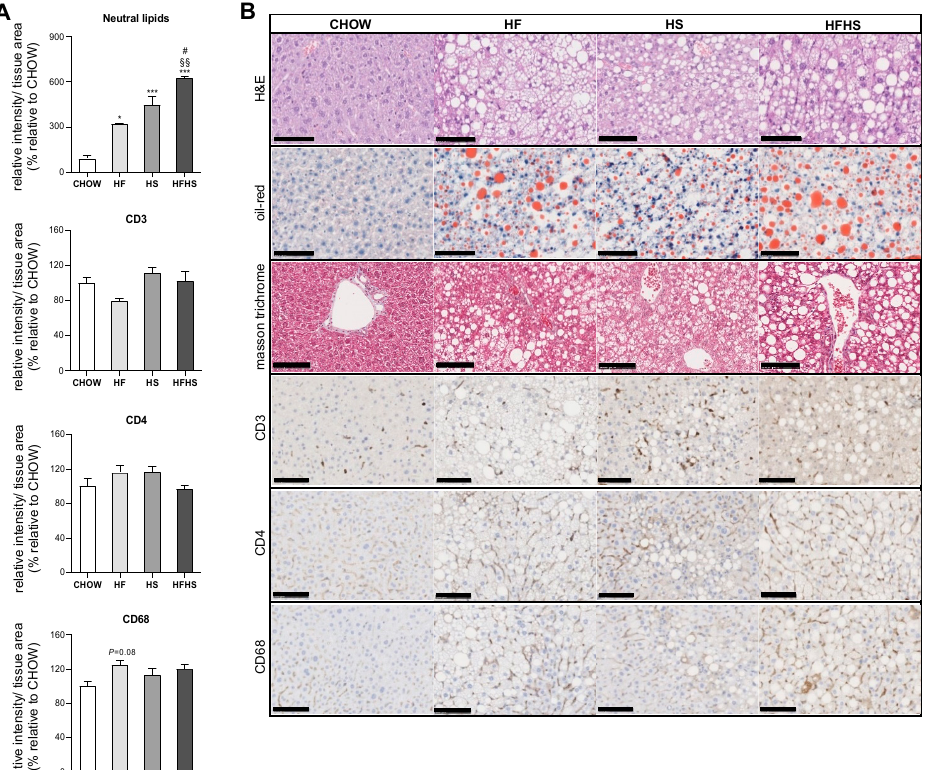
Figure 2. HF, HS and HFHS diets induce simple steatosis with no signs of lobular inflammation. ( A ) Hepatic content of neutral lipids and CD3, CD4 and CD68 inflammatory markers obtained from three independent images (per animal) from the experimental conditions shown in ( B ) ( N = 4). (B) Representative images of paraffin-embedded liver sections with H&E, Oil Red O, Masson’s trichrome, CD3, CD4 and CD68 immunostaining. Scale bar, 250 µm; magnification, 10×. All data are expressed as the mean ± SEM. (*) vs. the CHOW diet and (#) vs. the HS diet ( P < 0.05); (§§) vs. the HF diet ( P < 0.01); (***) vs. the CHOW diet ( P < 0.001); P values were determined using one-way ANOVA followed by Bonferroni’s post hoc test. H&E, hematoxylin and eosin; HF, high-fat; HFHS, high-fat plus high-sucrose; HS, high-sucrose.